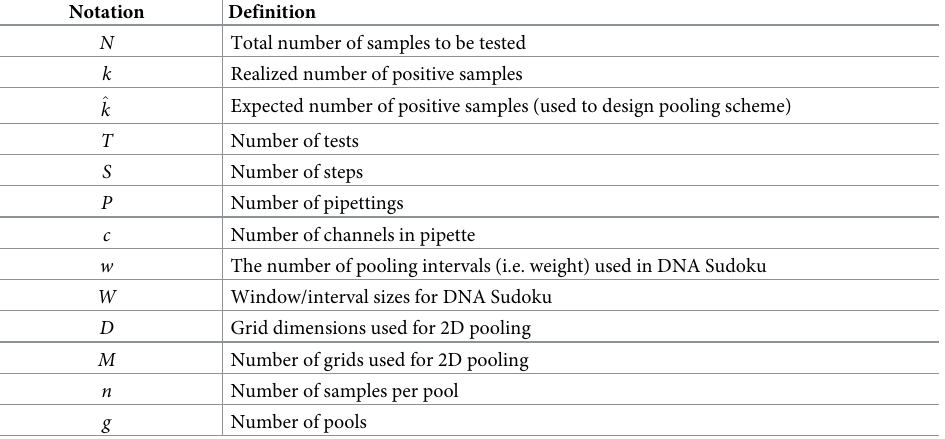
Table 1. Notation